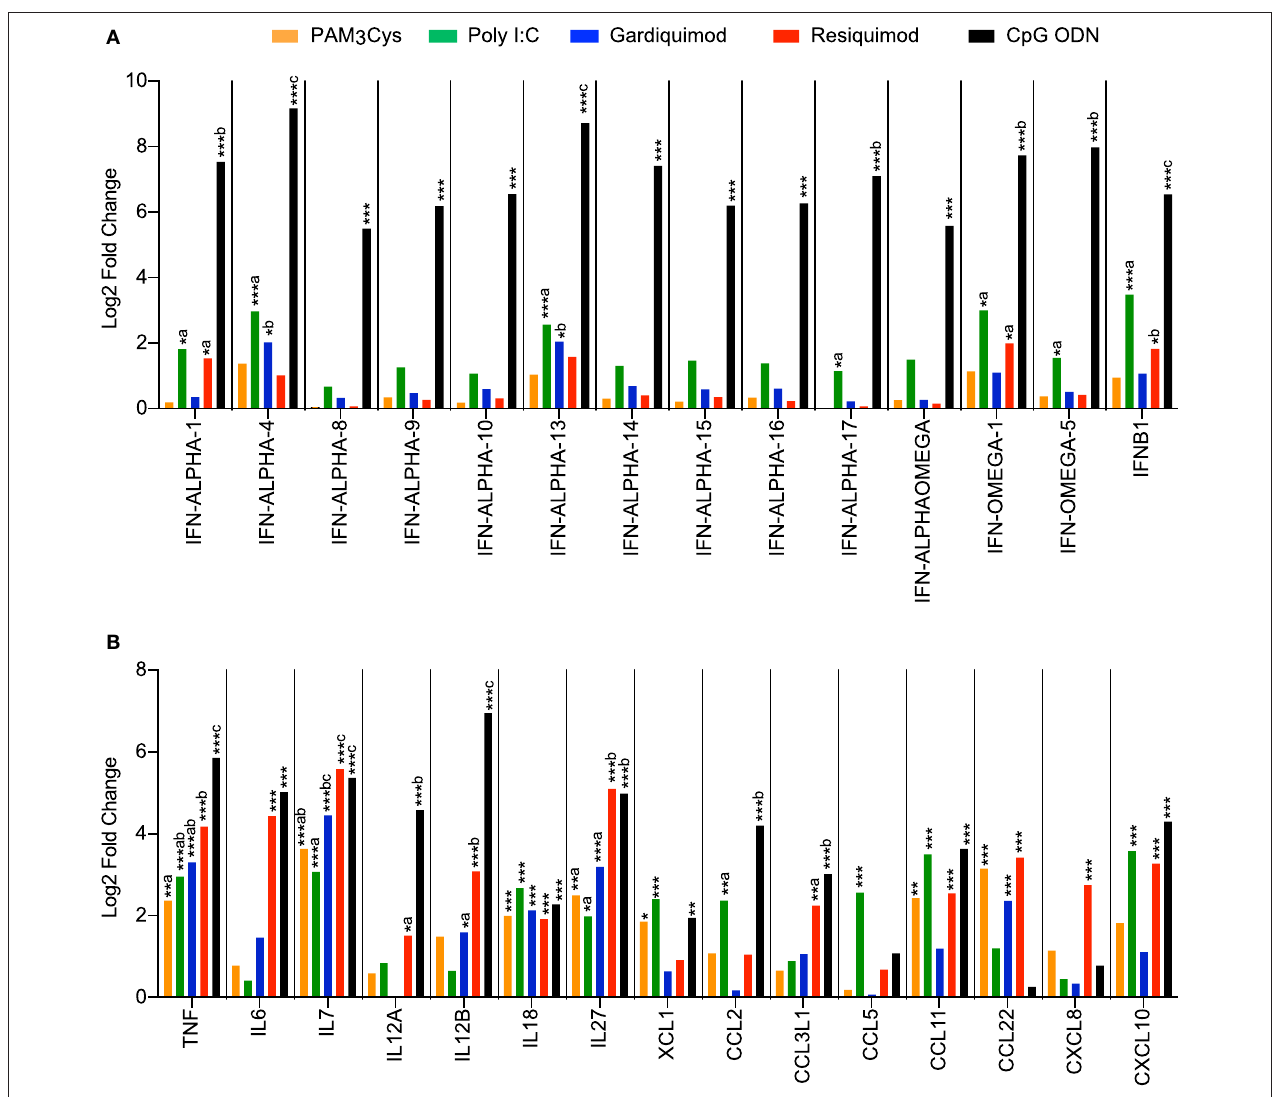
FIGURE 3 | Transcription profiles of porcine blood pDC stimulated with TLR ligands. pDC from 3 different animals were sorted by FACS and stimulated with 10 µ g/ml of PAM3Cys, 10 µ g/ml poly I:C, 5 µ g/ml gardiquimod, 5 µ g/ml resiquimod, 5 µ g/ml CpG ODN D32, or were left unstimulated as control. (A) Expression of selected type I interferon genes as log2 fold change between TLR ligand-stimulated pDC and control pDC. (B) Expression of selected cytokine and chemokine genes as log2 fold change between TLR ligand-stimulated pDC and control pDC. DESeq2 analysis * padj < 0.05, ** padj < 0.001, *** padj < 0.0001. For each gene, different letters represent statistical significance between two TLR-ligand stimulation groups as calculated by DESeq2